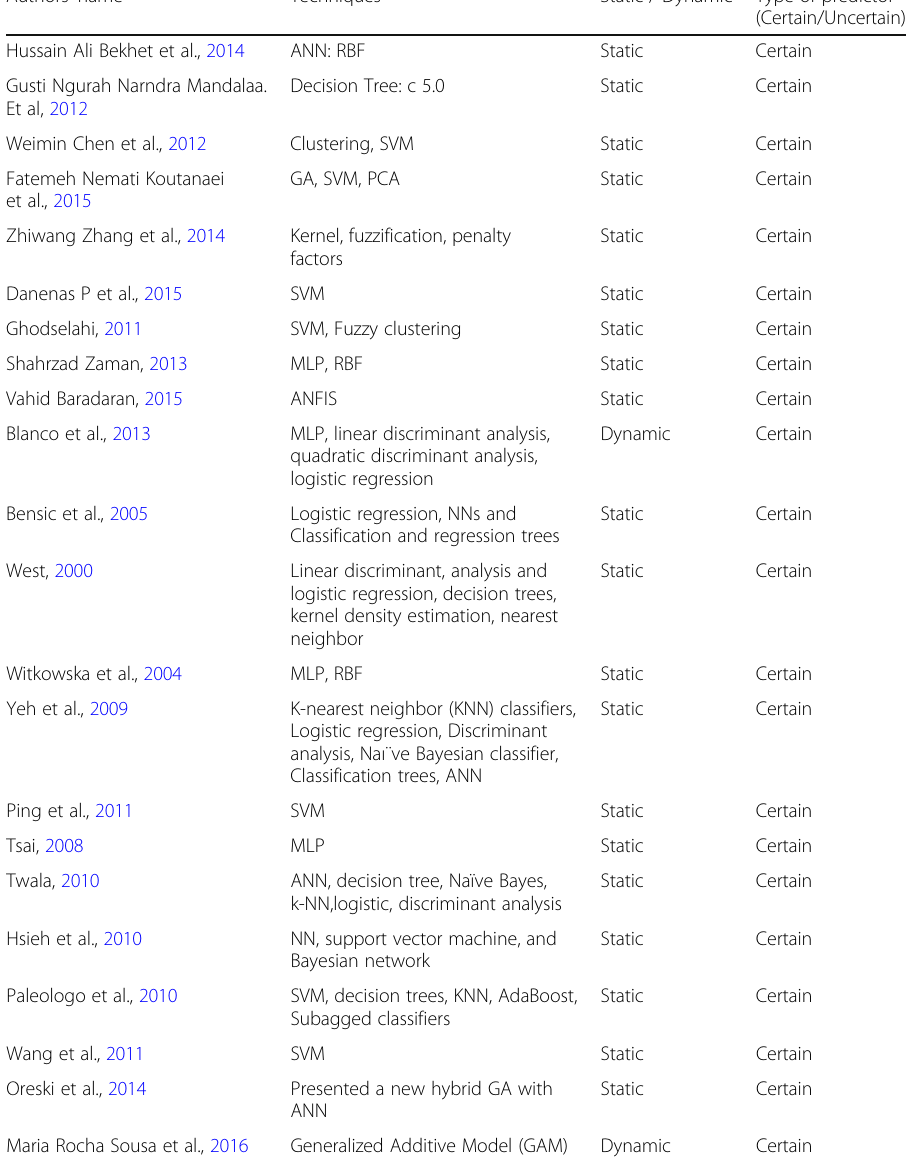
Table 1 Proposed models of credit risk. The researchers have tried to solve the customer credit risk assessment problem, using a different approach and technique, and each of them has tried to present a more accurate model than others. Table 1 summarizes these researches. It shows that 90.9% of the previous models are static and only 9.1% of them are